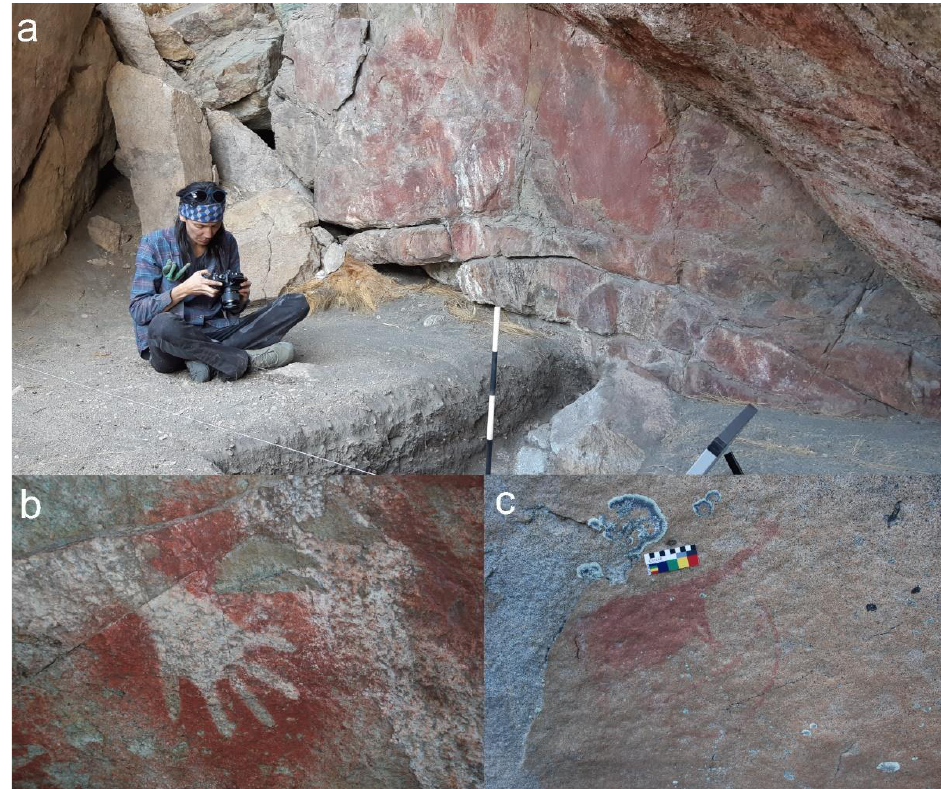
Figure 8. Rock art from the southern coast of General Carrera Lake: ( a ) excavations beside panel with painted hands at La Tina rock shelter; ( b ) stencil hands at La Tina rock shelter; ( c ) Lama guanicoe motif at Guanaca y Luna site at “Paso Las Llaves” sector.